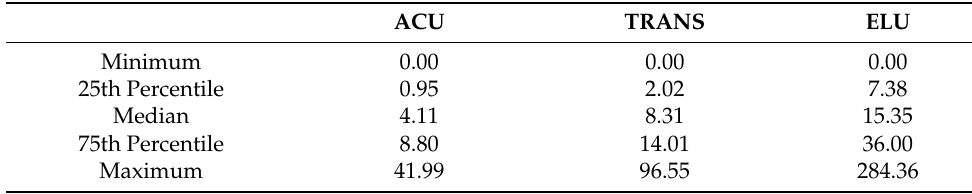
Table 1. Value of saturated hydraulic conductivity (cm · hr − 1